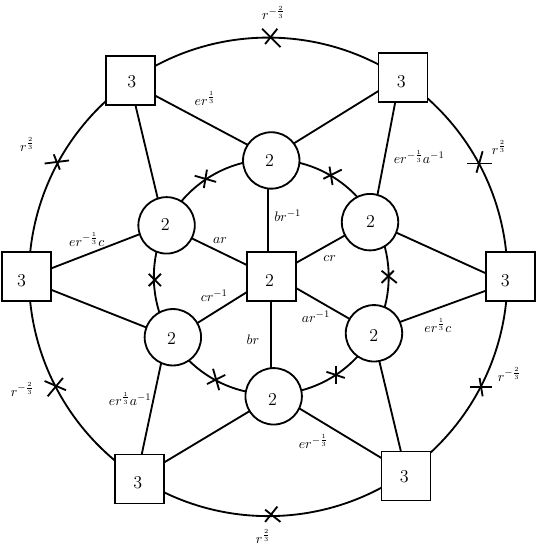
Figure 35 . The leg of torus with one unit of (cid:13)ux. The links of the quiver without the (cid:13)ip (cid:12)elds are charges with charge half under U(1) t , the (cid:12)elds with the (cid:13)ip are charged minus one. We denoted the other charges on the quiver with the charges of links with no labels derivable from superpotentials. The SU(2) explicitly visible in the quiver is SU(2) f